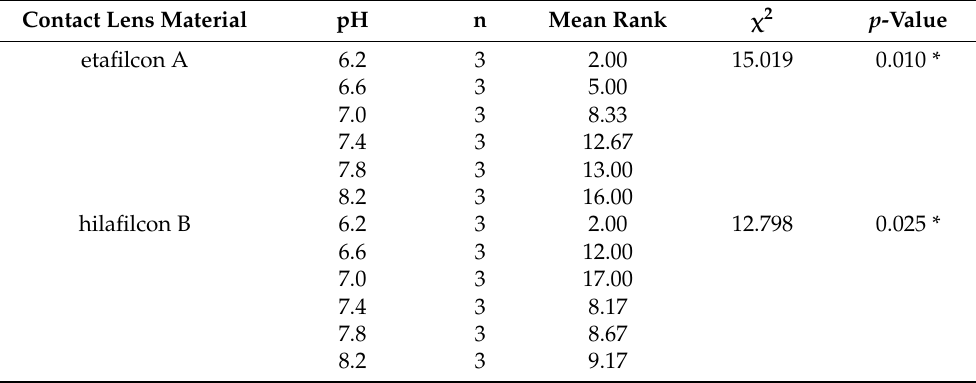
Table 4. The results of statistical analysis on the hydroxyl group content of etafilcon A and hilafilcon B equilibrated in PBS solution (pH 6.2–8.2). A repeated measures Kruskal–Wallis test was used for statistical analysis; * p <